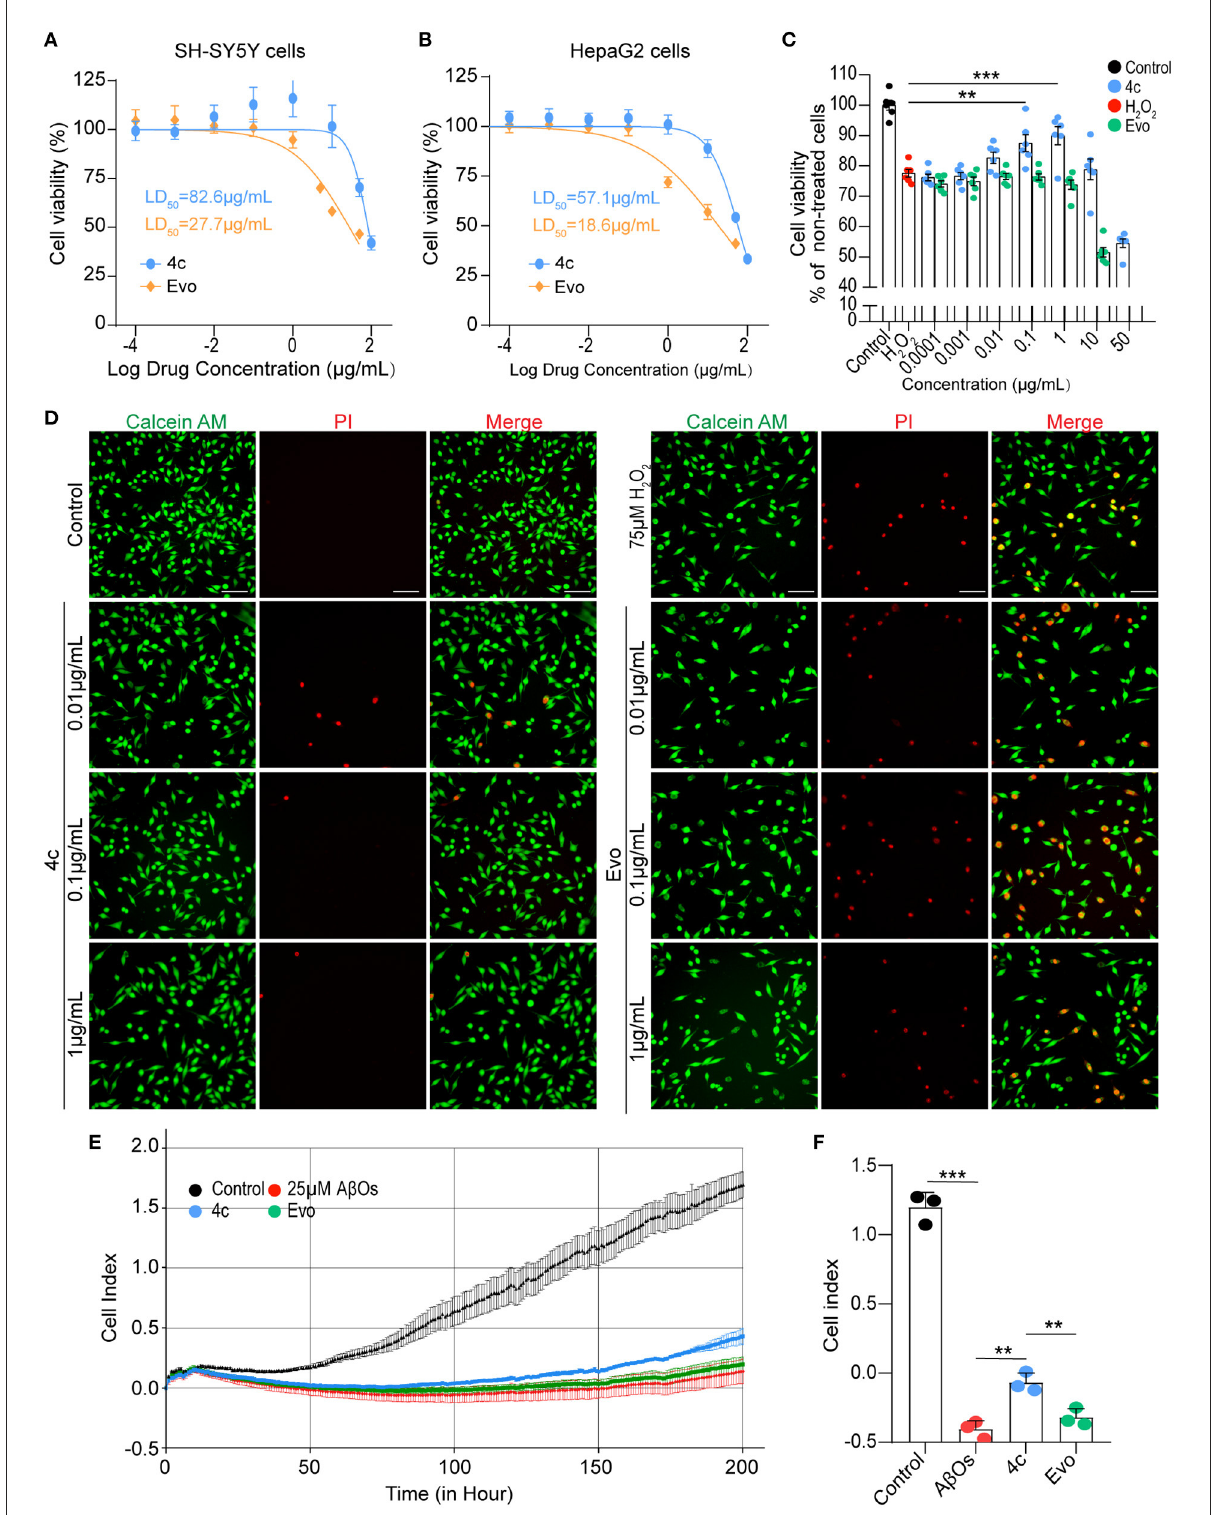
FIGURE3 Determination of the LD 50 of 4c and its effects against H 2 O 2 and A β Os. (A, B) The viability of SH-SY5Y and HepaG2 cells was determined by CCK8 after 24h of exposure to different concentrations of 4c (10 − 4 , 10 − 3 , 10 − 2 , 10 − 1 , 1, 10, 50, and 100 µ g/ml) and Evo (10 − 4 , 10 − 3 , 10 − 2 , 10 − 1 , 1, 5, 10, and 50 µ g/ml). The LD 50 values of 4c and Evo were estimated from the concentrations that resulted in 50% cell viability compared with